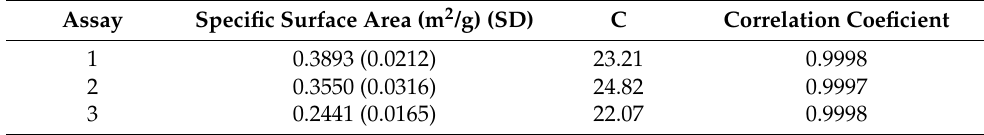
Table 1. Results of the specific surface area of the sample of Ti6Al4V powder. Assay Specific Surface Area (m 2 /g) (SD) C Correlation